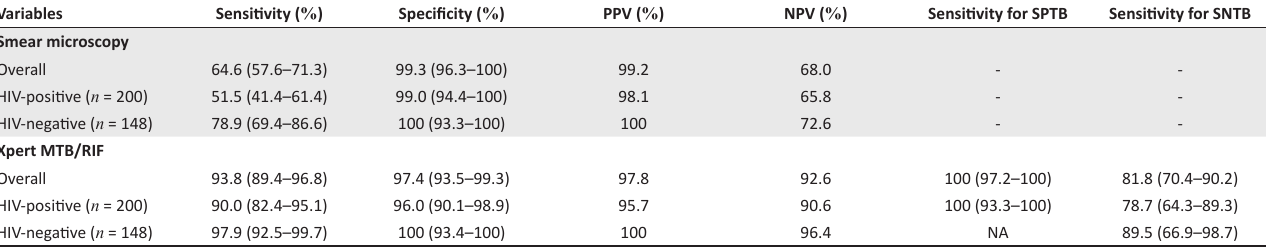
TABLE 2: Sensitivity, specificity, positive predictive value and negative predictive value of smear microscopy and Xpert MTB/RIF at 95 % CI compared with sputum culture for outpatients at Bwaila Hospital, Lilongwe, Malawi (2011–2012). Variables